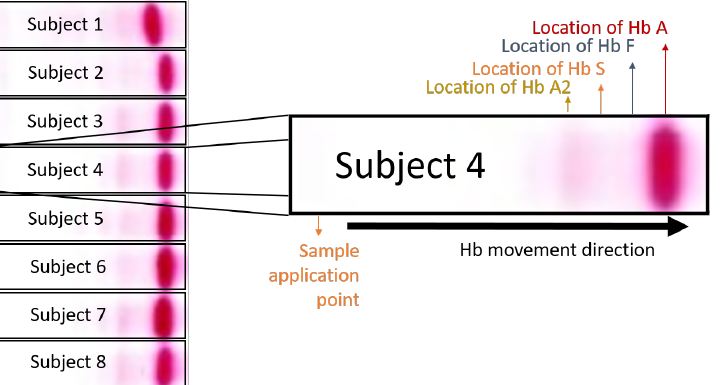
Figure 5. Description of a single electrophoresis image from a patient in an eight-patient strip